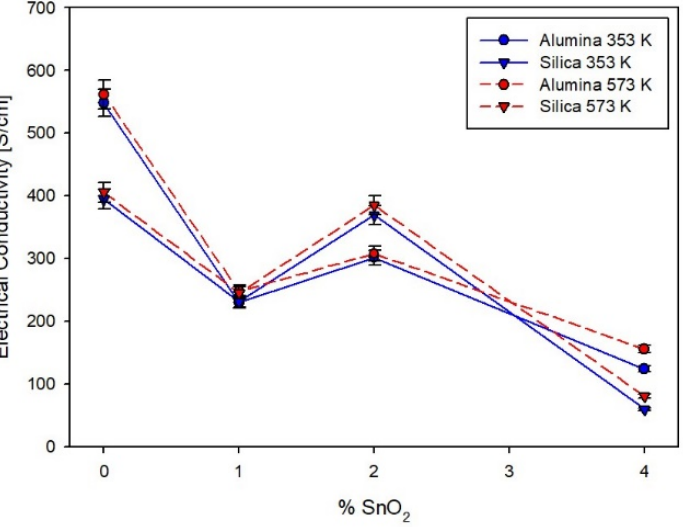
Figure B1. Electrical conductivity plotted versus the concentration of SnO 2 for the two series of films on silica and alumina.